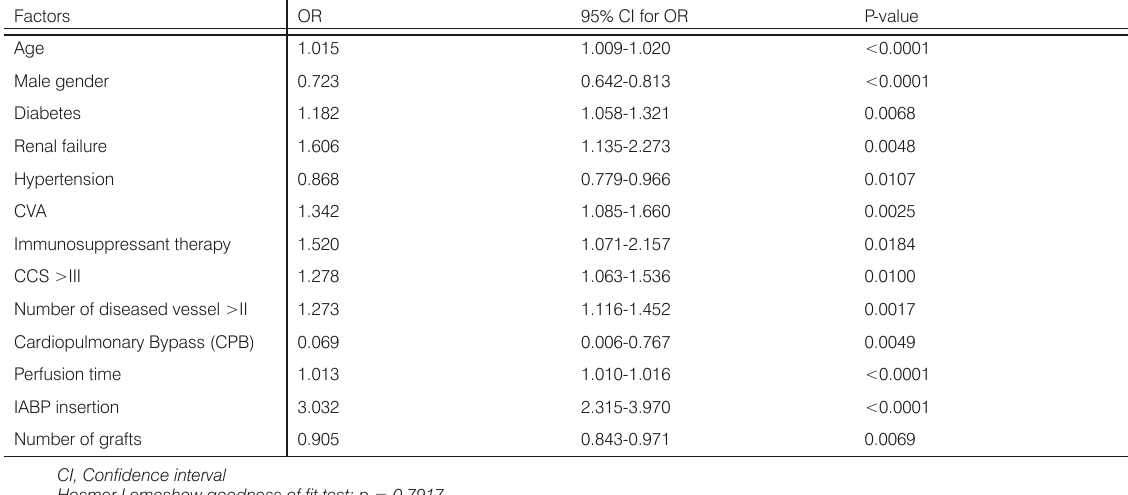
Table 3. Factors associated with homologous blood transfusion in patients underwent isolated CABG.